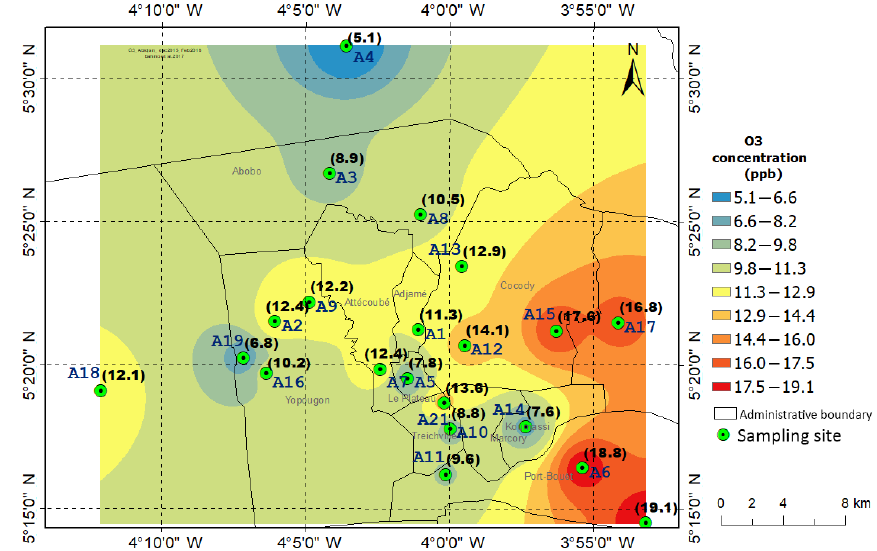
Figure 11. Spatial distribution of O 3 in the district of Abidjan during the dry season (15 December 2015–16 February 2016). Measured concentrations inppb are in